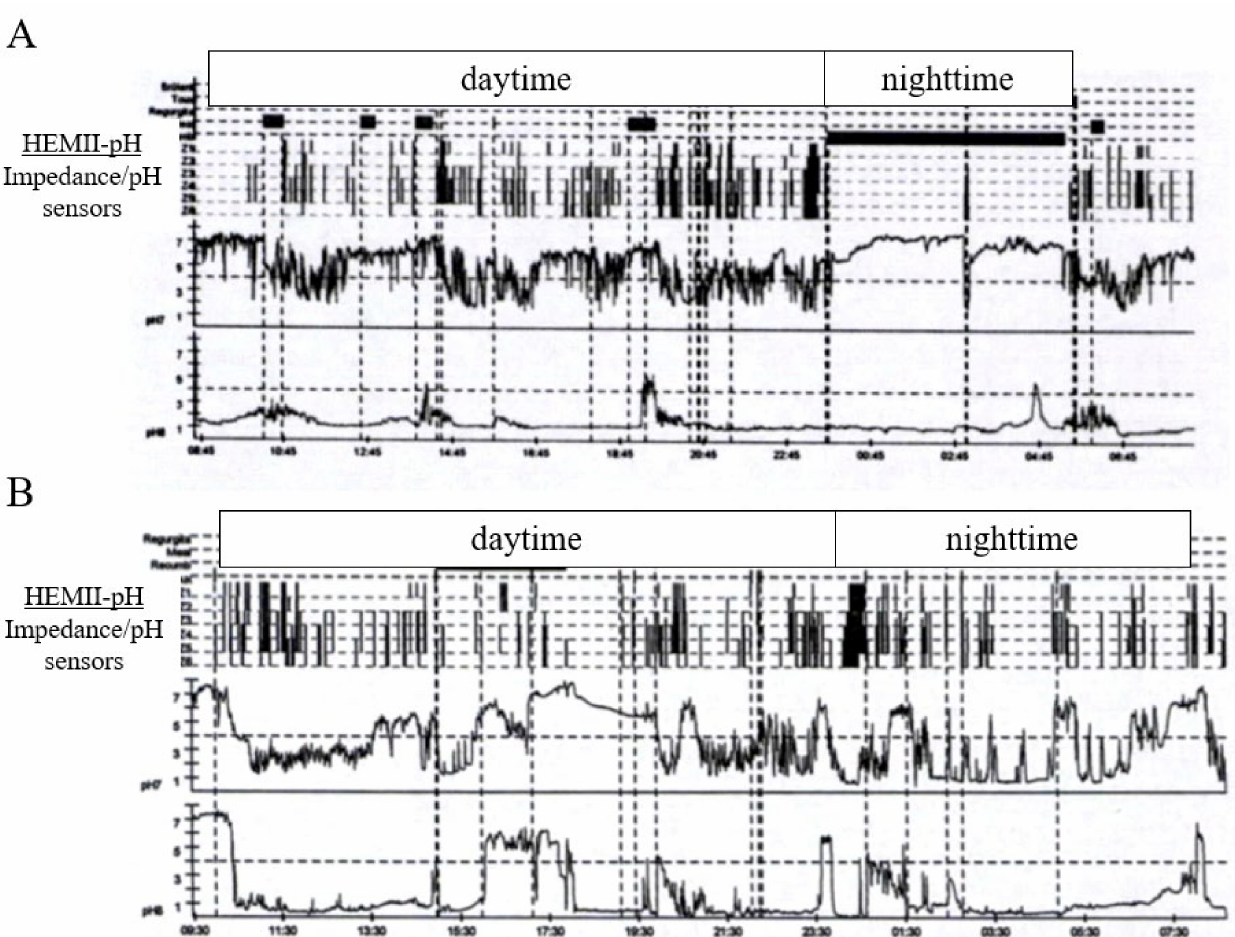
Figure 1. pH-impedance profiles of patients with gastroesophageal reflux disease and laryngopha- ryngeal reflux. Two main profiles of LPR patients at the HEMII-pH are observed: patients with daytime hypopharyngeal reflux episodes ( A most of cases) and patients with daytime and night- time hypopharyngeal reflux episodes ( B ). Abbreviations: GERD, gastroesophageal reflux disease; HEMII-pH, hypopharyngeal-esophageal multichannel intraluminal impedance–pH monitoring; LPR, laryngopharyngeal